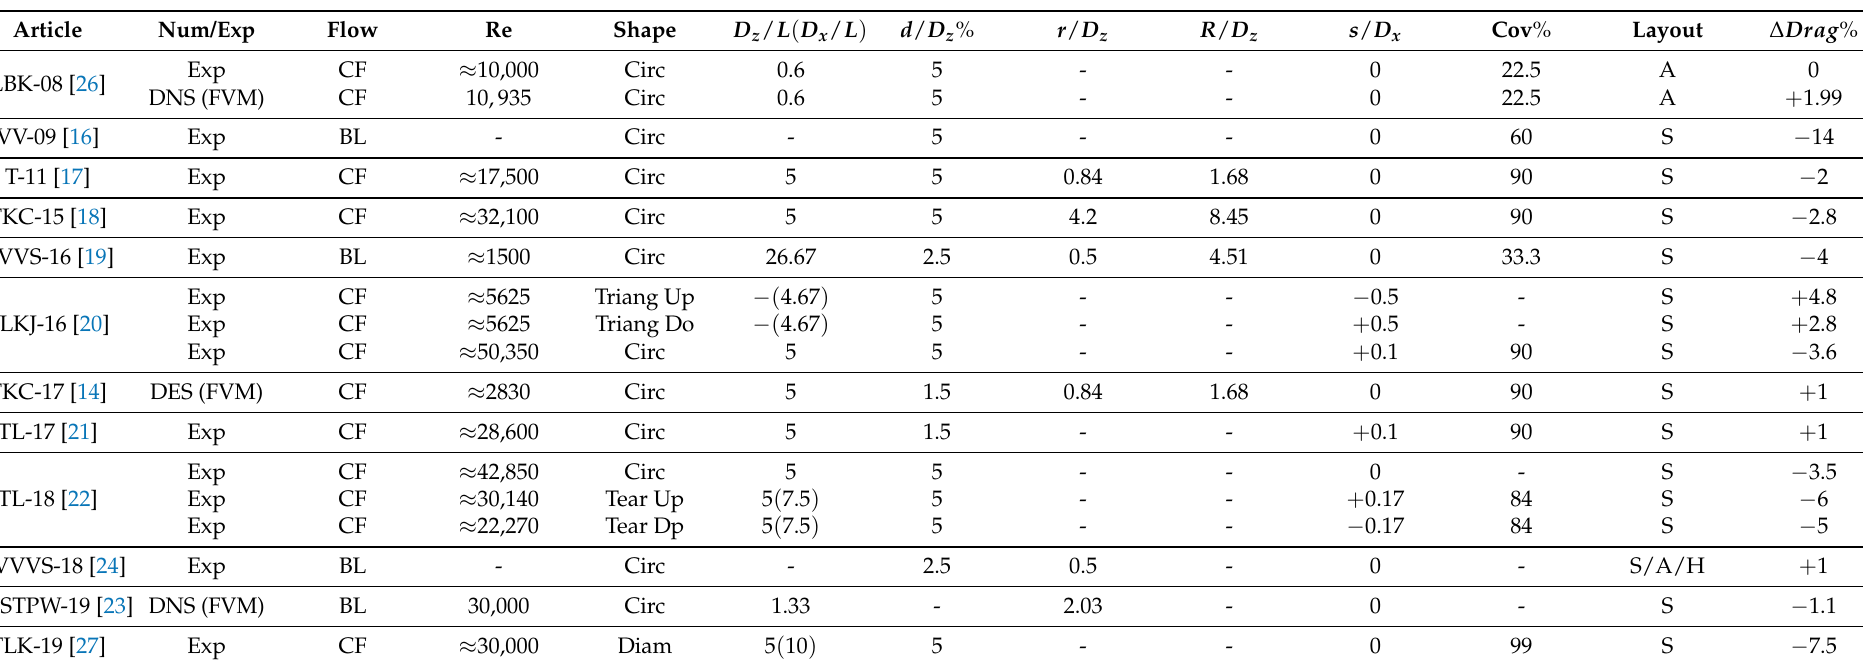
Table 1. Summary of the main parameters and results of the literature. Columns report, in sequential order: 1. the reference and its acronym; 2. the numerical (DNS: direct numerical simulation, LES: large eddy simulation, DES: detached eddy simulation, FVM: finite volume method, SEM: spectral element method) or experimental approach; 3. the flow type: channel flow (CF), half-channel flow (HCF) or boundary layer (BL); 4. the value of the Reynolds number: Re b for CF and HCF, Re δ for BL (other Re definitions for CF are converted to Re b using Dean’s law); 5. the dimple shape: circular (Circ), triangular (Triang), diamond (Diam), elliptical (Ell), teardrop (Tear), upstream-pointing (Up), Downstream-pointing (Do); 6. spanwise width D z and streamwise length D x , expressed as a fraction of the reference length L (the channel half-height h for CF and the boundary layer thickness δ for BL), for a circular dimple D z = D x , thus only one value is reported; 7. the dimple depth d ; 8. the edge curvature radius r ; 9. the curvature radius R of the spherical cap; 10. the shift s of the point of maximum depth; 11. the coverage ratio; 12. the type of layout: S: staggered, A: aligned, H: hexagonal; 13. the percentage drag change. “-” is used when some information required to compute the value is